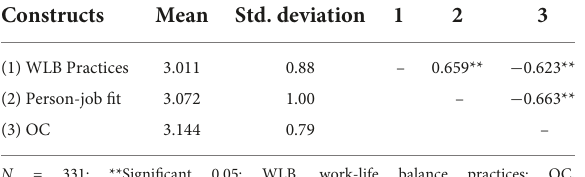
TABLE 1 Descriptive statistics.